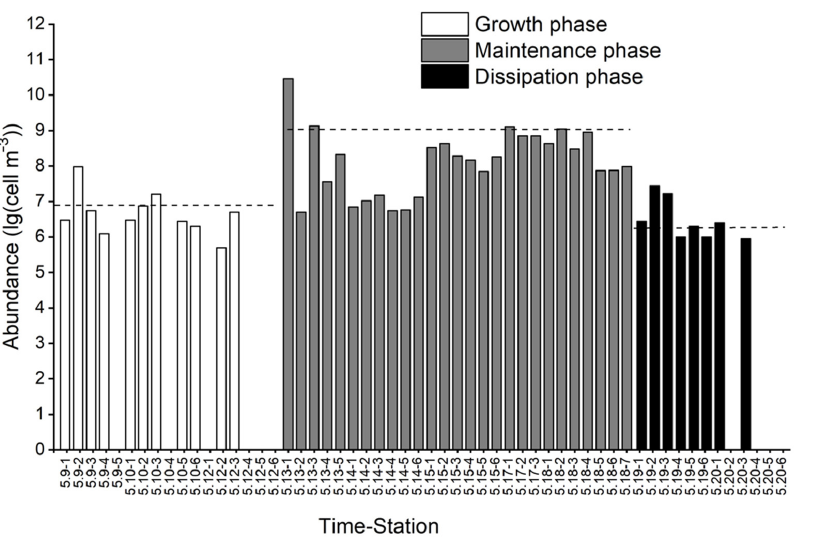
Figure 2. The abundance of P. donghaiense at each sampling station in different phases of the P. donghaiense bloom (remarks: the dash represents average value). During the investigation period, the variation range of physical parameters is small (Supplemental Table S3), the average values of depth of sample, temperature, pH, salin-